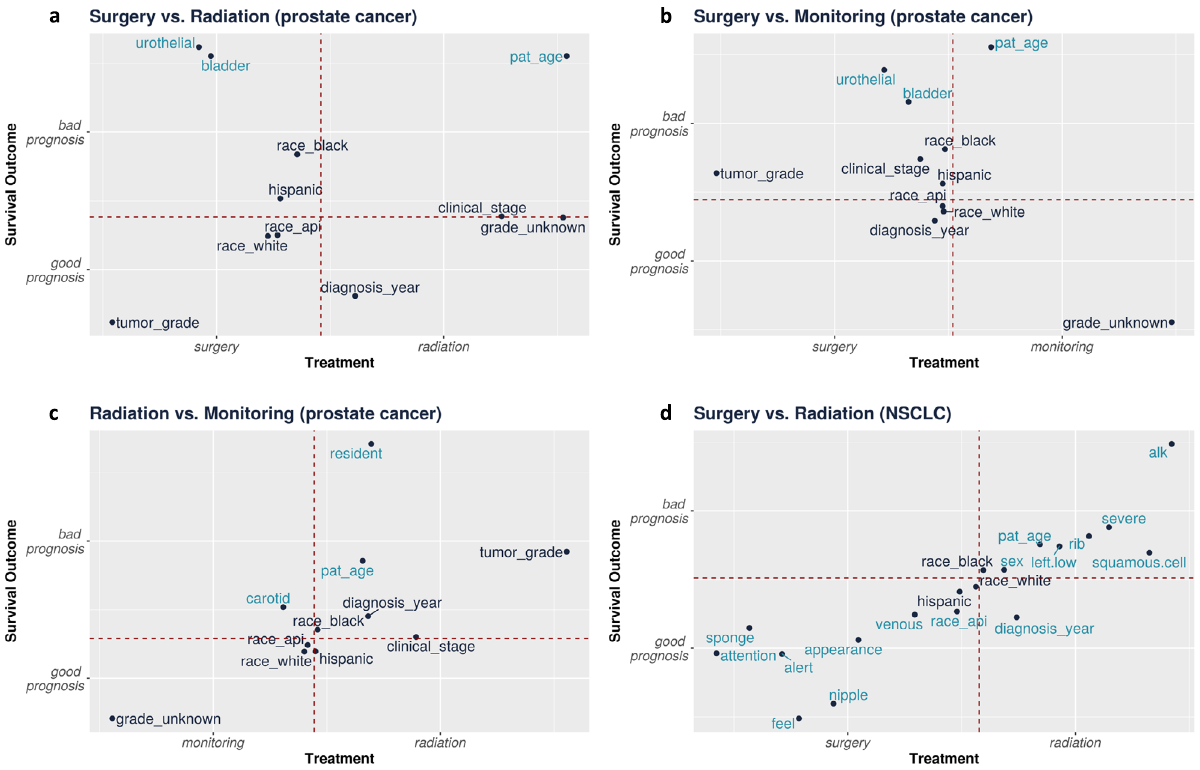
Fig. 2 For each treatment group, we show the unpenalized coef fi cients for the struct + intersect covariates. Blue text indicates the intersect covariates that have been selected as potential confounders by our method from the text; the pre fi x text: has been omitted. Black text indicates the structured covariates that have not been selected; the pre fi x “ struct:" has been omitted. The covariate patient_age has been shorthanded as pat_age. For the treatment model, these are the coef fi cients to a linear model. For the survival outcome model, these are the β for the Cox-PH model. The dotted lines are the axis, denote a coef fi cient value of 0. We plot the coef fi cients from the survival and treatment regression models in each of the fi gure panels: a surgery vs. radiation for prostate cancer; b surgery vs. monitoring for prostate cancer; c surgery vs. monitoring for prostate cancer; d surgery vs. radiation for